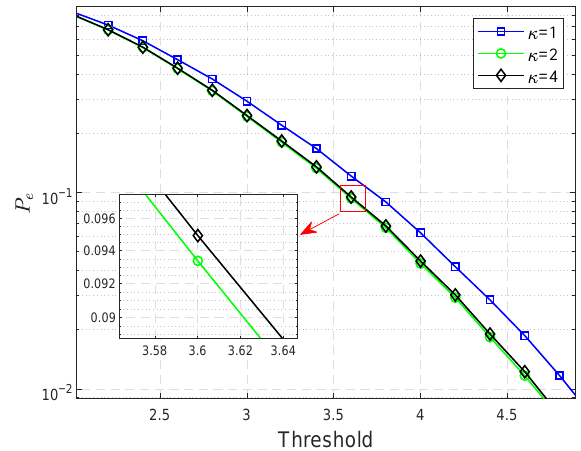
Figure 9. P e versus discrimination threshold.